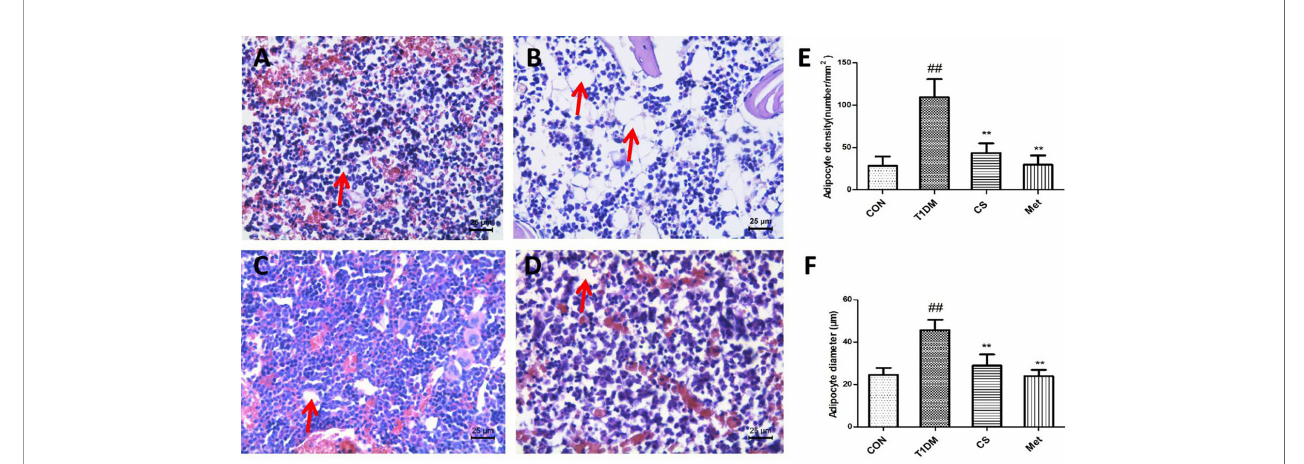
FIGURE 7 | Adipocytes in the bone marrow cavity of the tibia in different groups at the end of the 10th week, H&E staining. (A) The control group tibia bone marrow. (B) The diabetic group tibia bone marrow. (C) The CS group tibia bone marrow. (D) The Met group tibia bone marrow. (E) Adipocyte density in different groups. (F) Adipocyte diameter in different groups. ## indicates p < 0.01 compared with control. **indicates p < 0.01 compared with the diabetic group. Red arrows indicate